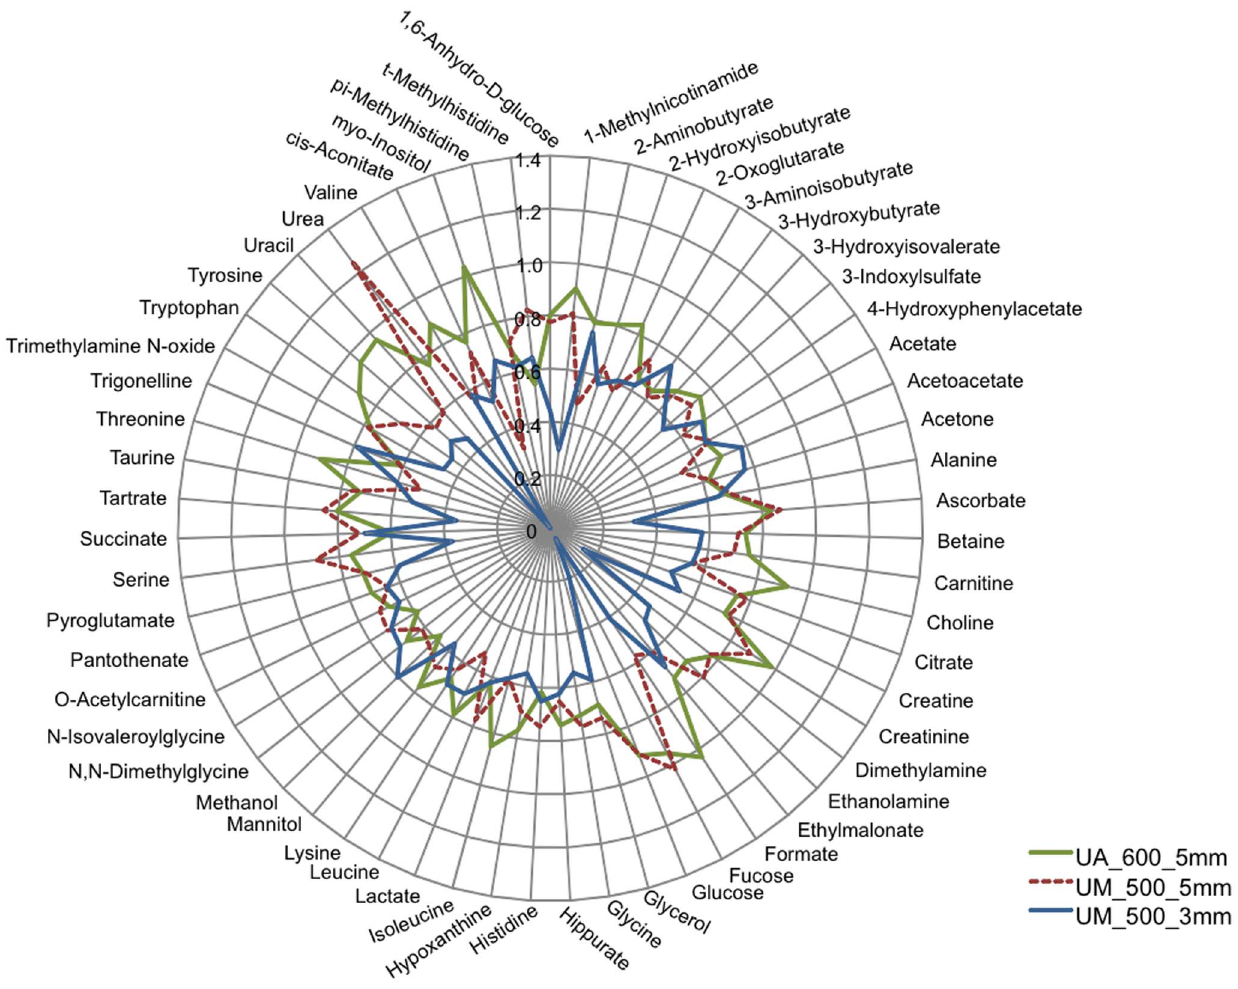
Figure 3. Radar plot of the normalized quantified 1 H-NMR urine metabolites. The plot permits the visualization of the similarities and discrepancies between the data generated using a 5 mm probe (University of Alberta (UA), and University of Michigan (UM)), and a 3 mm probe (UM). The data are the mean of the normalized values for each metabolite. Overall, the results from the 5 mm probes are more similar to each other than those from the 3 mm probe (also see Fig. S2 and Fig. S3).